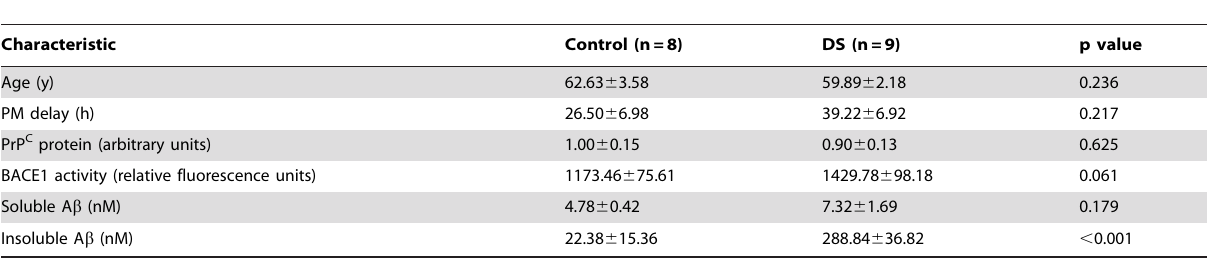
Table 2. Summary data of the DS and age-matched control